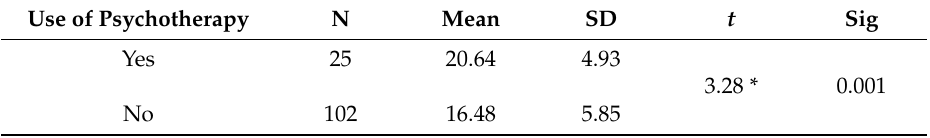
Table 3. t -test for prior use of psychotherapy on attitudes towards help seeking. Use of